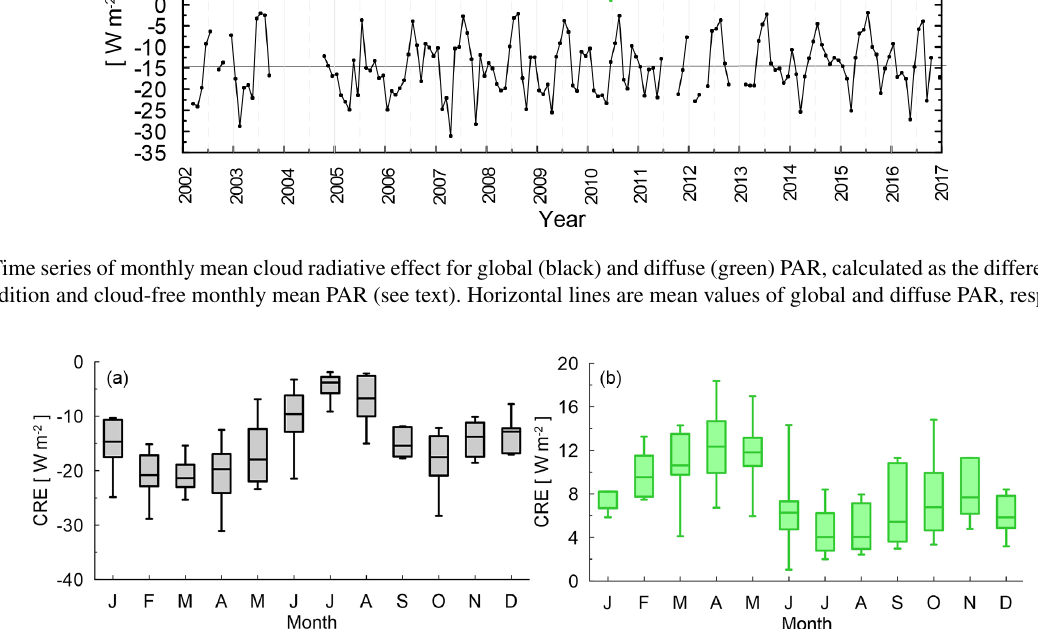
Figure 9. Annual evolution of global (a) and diffuse (b) PAR CRE. Maxima, upper quartile, median, lower quartile, and minima of the monthly values are